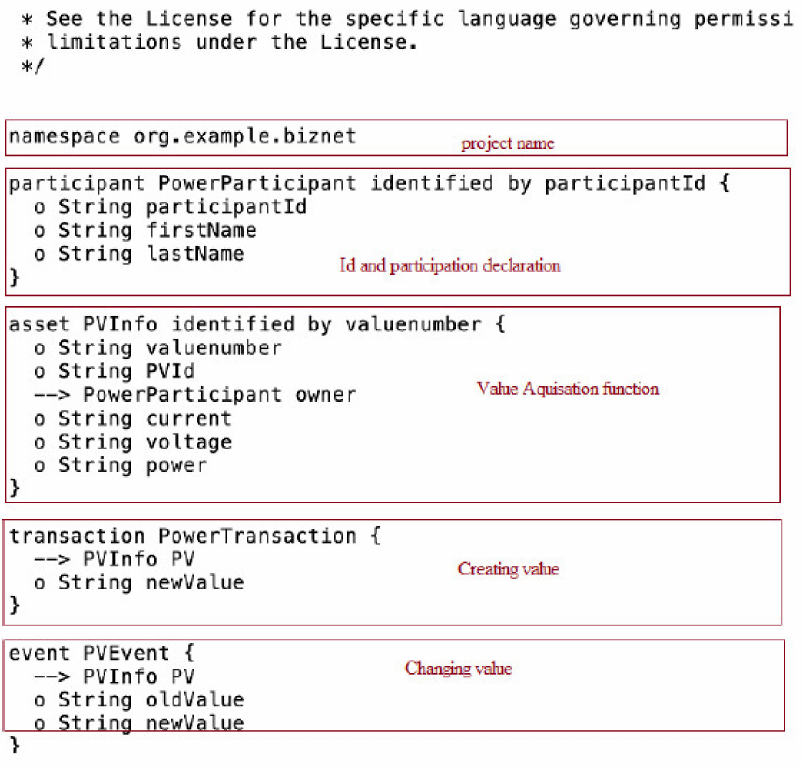
Figure 12. Sample chain